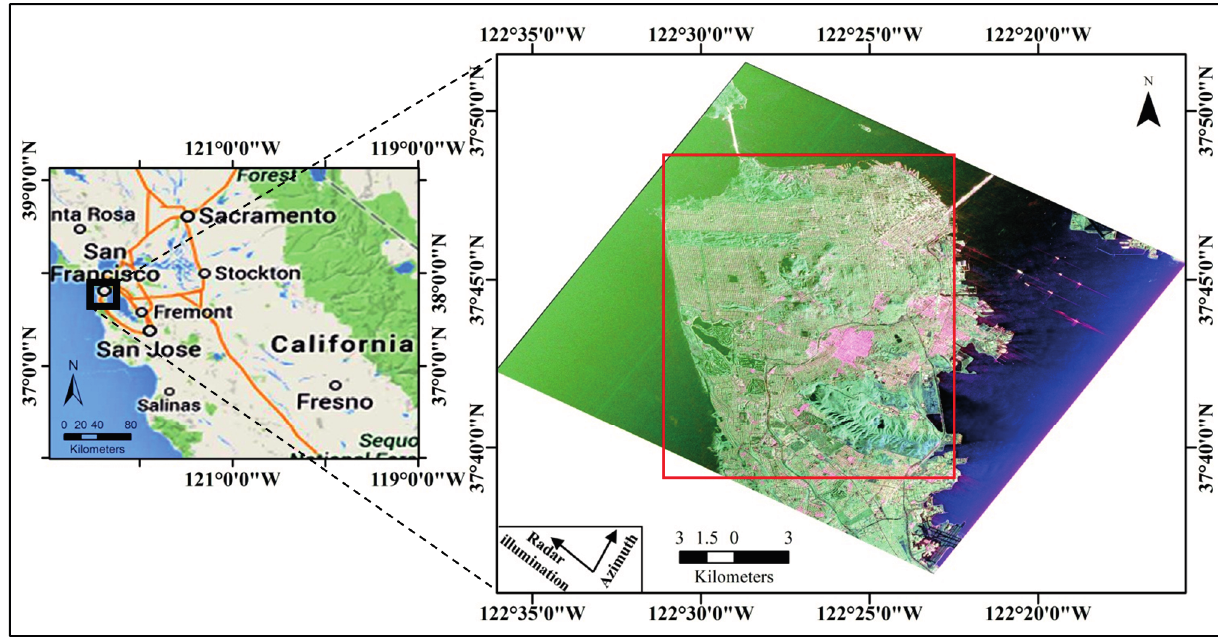
Figure 1. AIRSAR C-band polarimetric image of San Francisco with Pauli color-coding (Red: |HH − VV|, Green: |HV|, Blue: |HH + VV|). HH (horizontal transmit and horizontal receive), HV (horizontal transmit and vertical receive), VV (vertical transmit and vertical